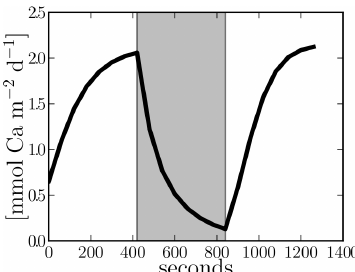
Fig. 7. Net calcification rate over time. Light periods range from 0 to 420s and from 840 to 1260s. The dark period is between 420 and 840s.